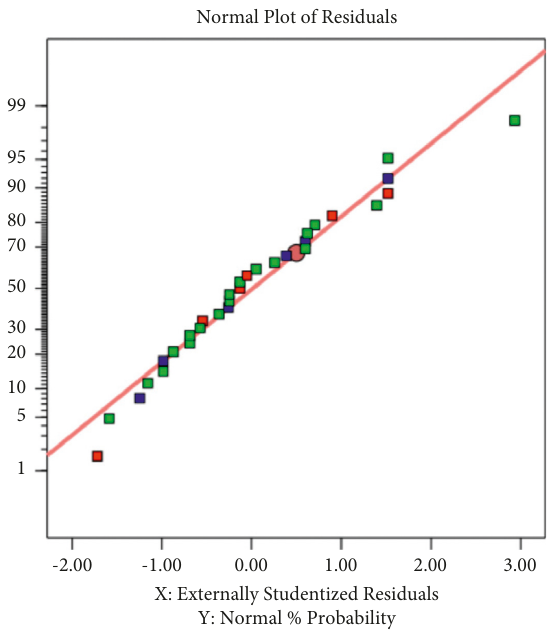
Figure 7: Accuracy of observations of kerf width. Figure 8: Predicted response versus actual response of kerf